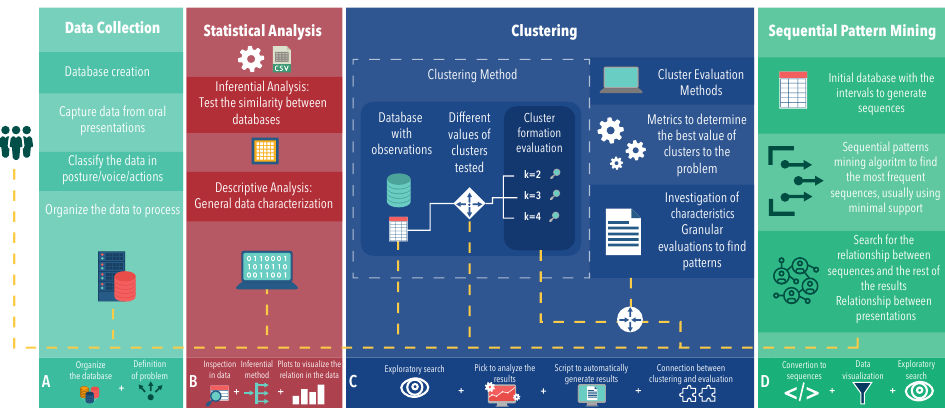
Figure 1. Conceptual framework